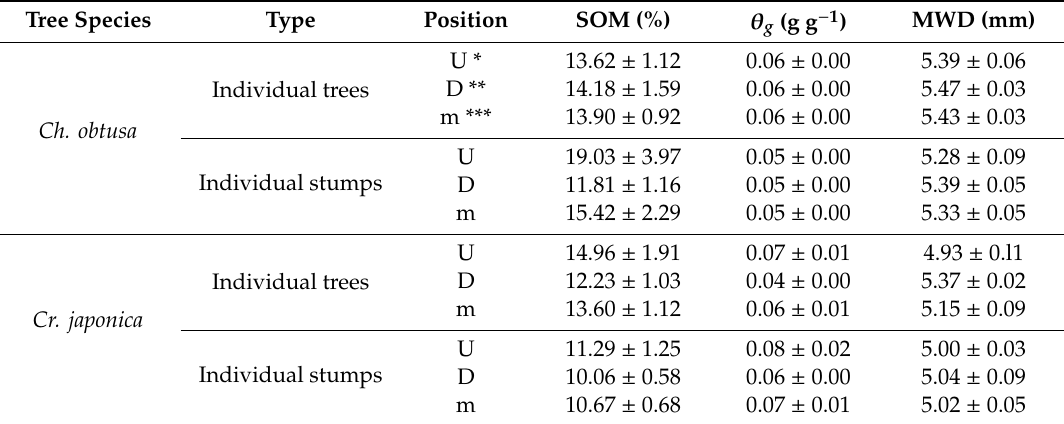
Table 2. Soil organic matter (SOM), air-dried-soil gravimetric water content ( θ g ), and aggregate mean weighted diameter (MWD) from 5-cm soil depth of Chamaecyparis obtusa and Cryptomeria japonica intact tree and cut tree plots.